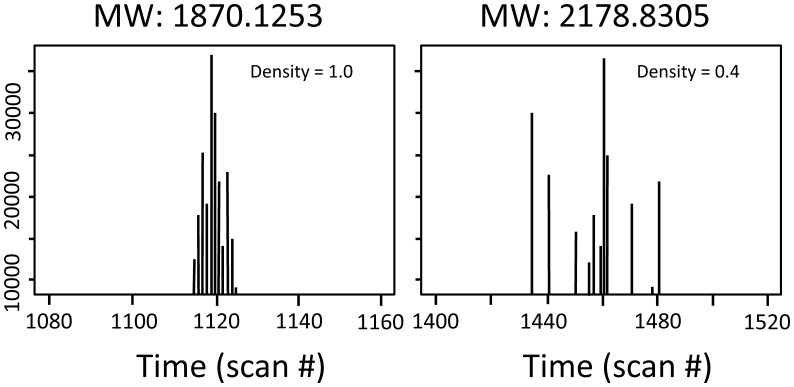
Two example candidate compounds representing a densely eluting compound (left) and a sporadically eluting compound (right).